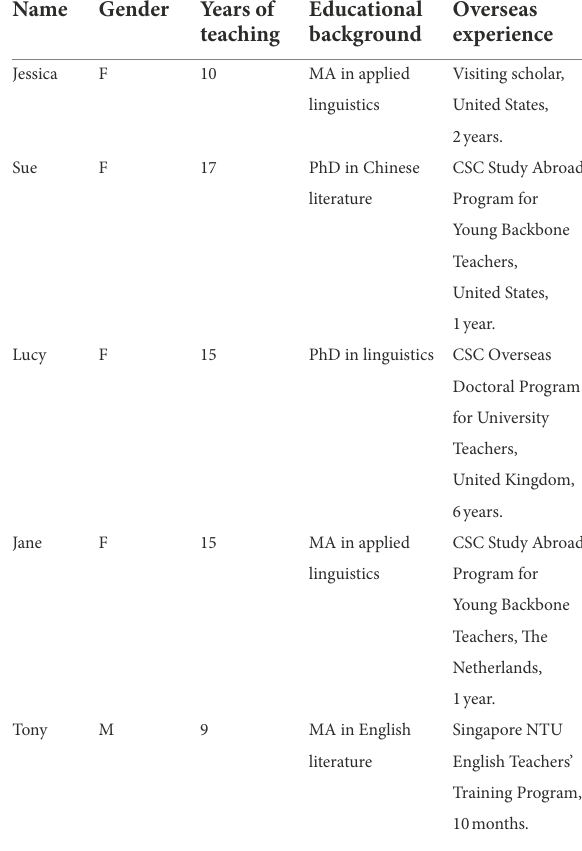
TABLE 1 Background information of the